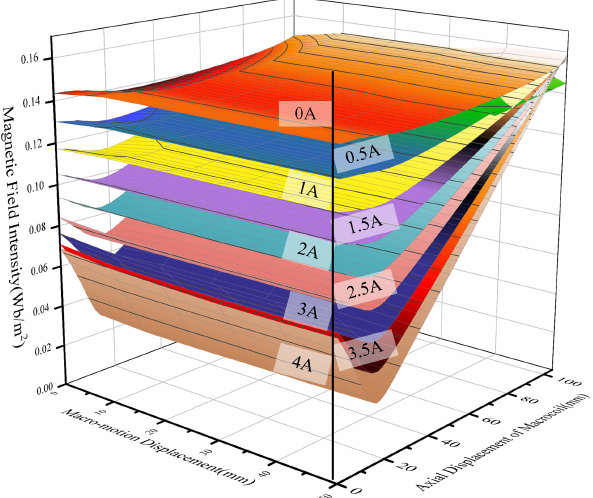
Figure 9. The relationship curve between the magnetic field inten- sity at the working air gap of the macro-motion part and the position of the mover and the macro-motion current.